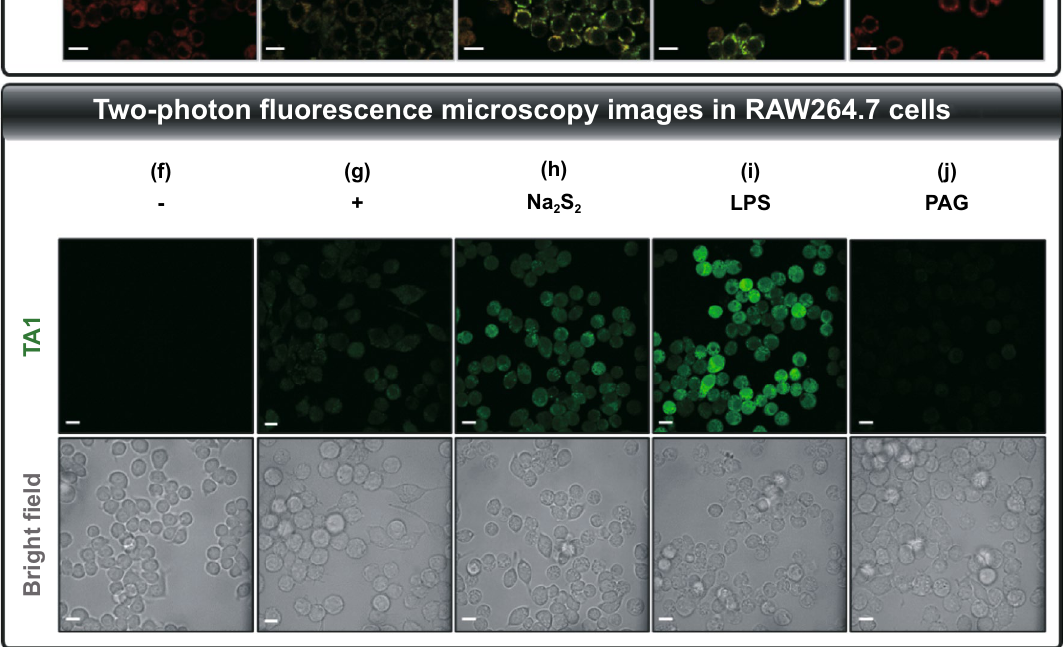
Fig. 3 Confocal fluorescence microscopy images in RAW264.7 cells incubated with TA1 (10 μM) for 2 h. The cells in each group were sub- jected to different treatments. a Control (1% DMSO), b TA1 , c TA1 + Na 2 S 2 (5 μM), d TA1 + LPS (1 μg mL −1 ), e TA1 + PAG (1 mM). Fluo- rescence images of cells were collected at λ ex = 488 nm, λ em = 500–560 nm of TA1 and at λ ex = 579 nm, λ em = 580–620 nm of Mito-tracker. Two-photon fluorescence microscopy images in RAW264.7 cells incubated with TA1 (10 μM) for 2 h. The cells in each group were subjected to different treatments. f Control (1% DMSO), g TA1 , h TA1 + Na 2 S 2 (5 μM), i TA1 + LPS (1 μg mL −1 ), j TA1 + PAG (1 mM). Fluorescence images of cells were collected at λ ex = 800 nm, λ em = 500–600 nm. Scale bar = 100